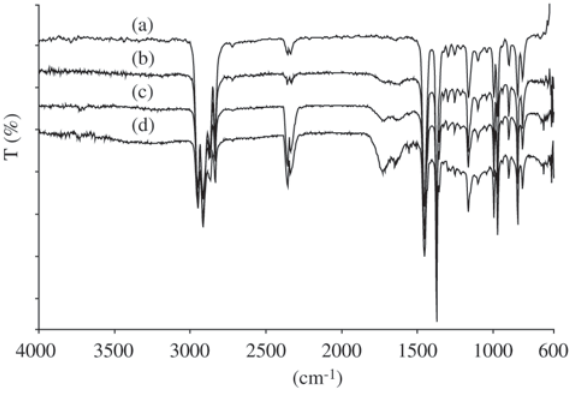
Figure 1. FTIR/ATR spectra for (a) untreated; (b) 2 s; (c) 10 s; (d) 30 s corona treated PP films.